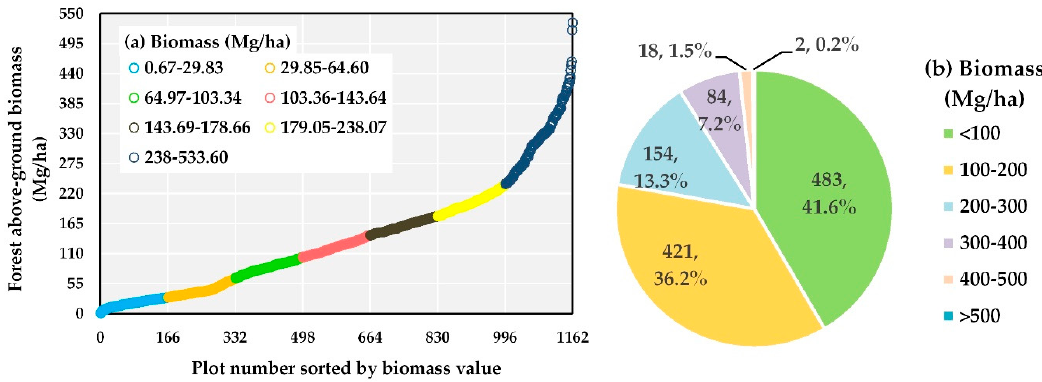
Figure 2. The values of measured above-ground biomass (AGB). ( a ) Field plot profiles of AGB in the study site from Plot 1 to 1,162; ( b ) Components of AGB.